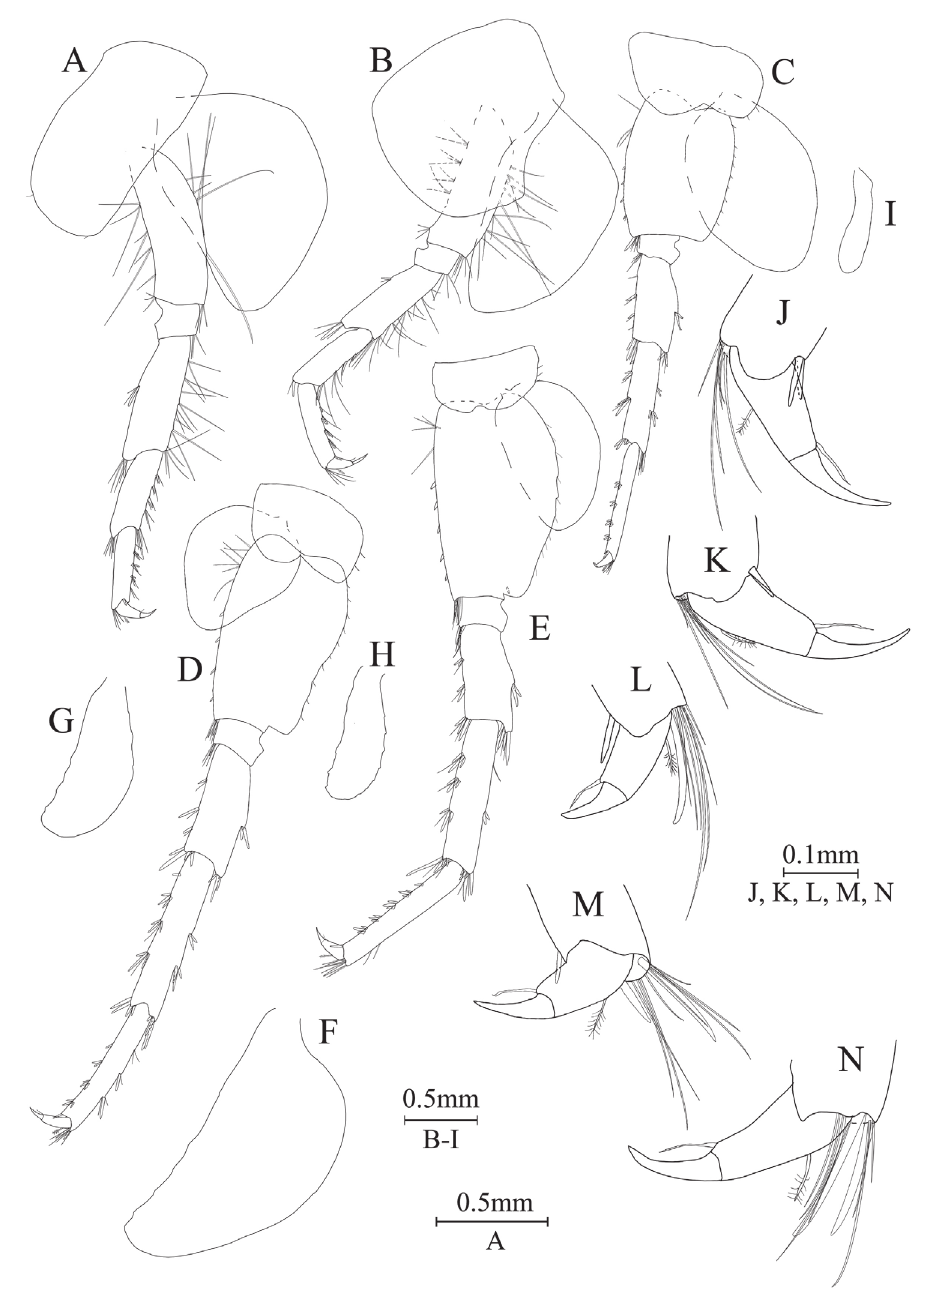
Figure 10. Gammarus zhouqiongi sp. nov., female paratype (GAHBH-002) A pereopod III B pereopod IV C pereopod V D pereopod VI E pereopod VII F oostegite of gnathopod II G oostegite of pereopod III H oostegite of pereopod IV I oostegite of pereopod V J dactylus of pereopod III K dactylus of pereopod IV L dactylus of pereopod V M dactylus of pereopod VI N dactylus of pereopod